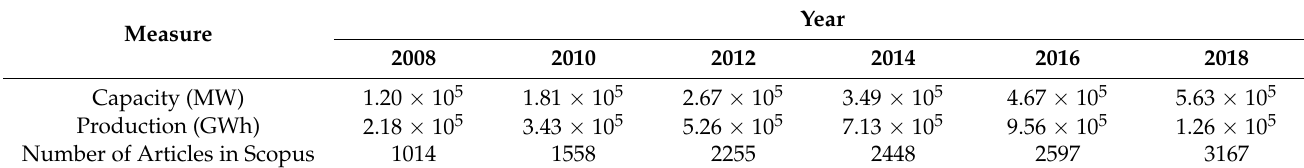
Table 1. Wind energy data (data collected from [1] and Scopus database).